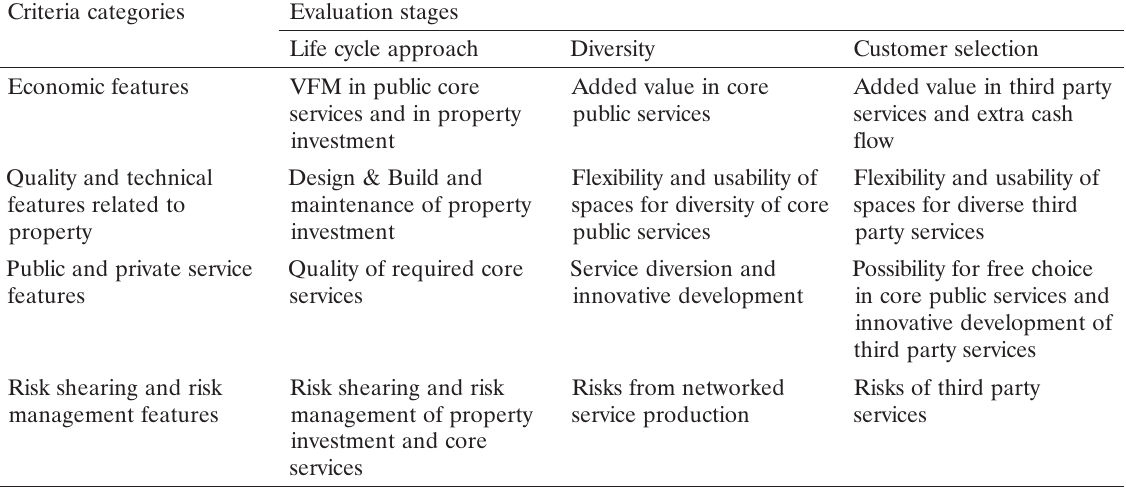
Table 3. Customer orientated stages and criteria for evaluation in the purchasing process for 4P projects